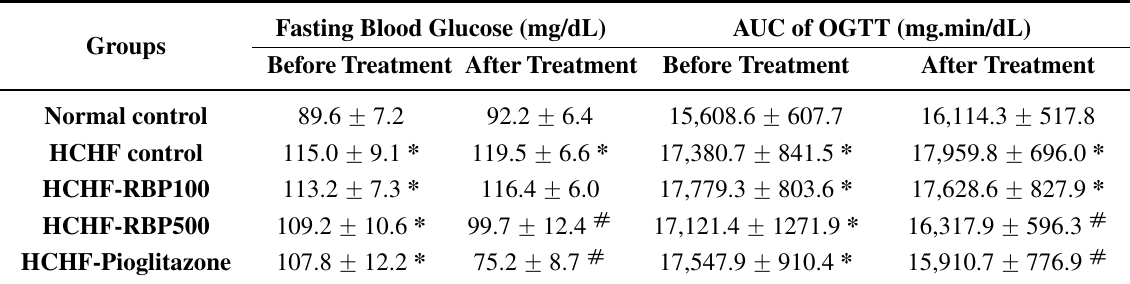
Table 4. Effect of RBP on FBG and OGTT in HCHF- rats.